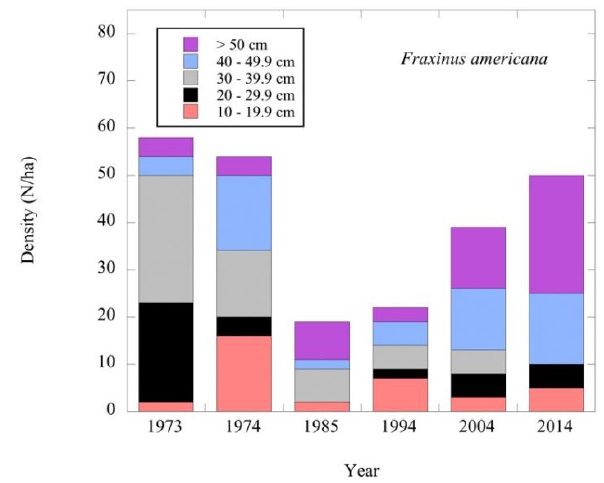
Forests 2019 , 10 , x FOR PEER REVIEW Figure 3. Density (N/ha) distribution by diameter class (DBH ≥ 10.0 cm) of Acer saccharum individuals recorded across the six sampling periods at Dinsmore Woods.